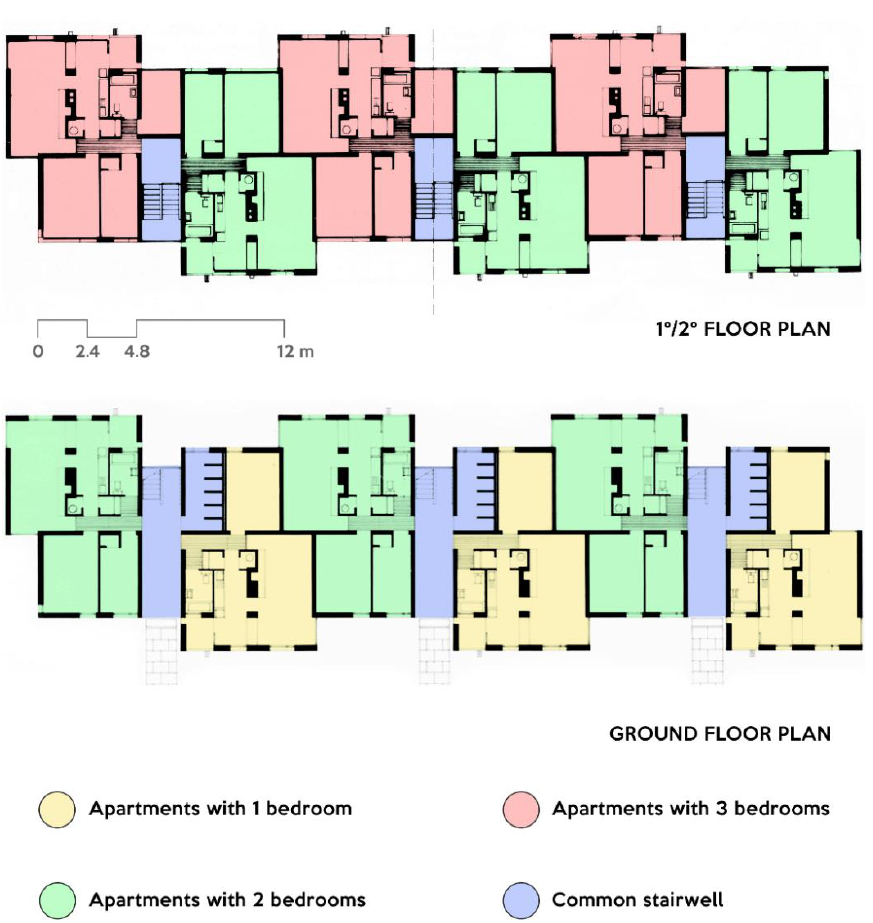
Figure 6. Plans of the building.